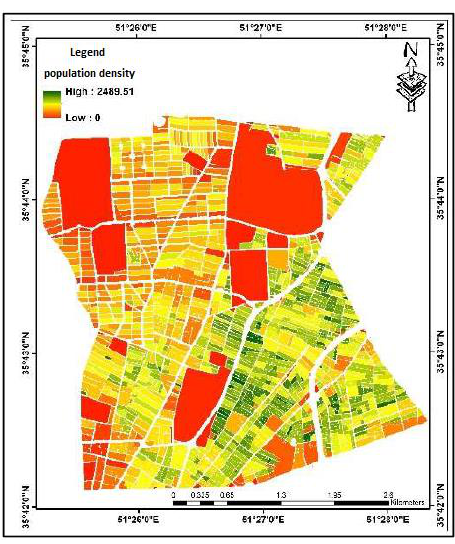
Figure 7. Fuzzy distance from fuel stations.